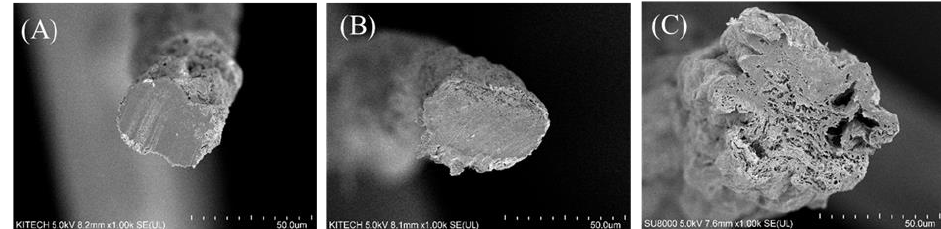
Figure 4. Cross section of single composition collagen fibers. ( A ) porcine, ( B ) tilapia skin-based, and ( C ) flatfish-skin-based collagen. The scale of all figures is 50.0 µ